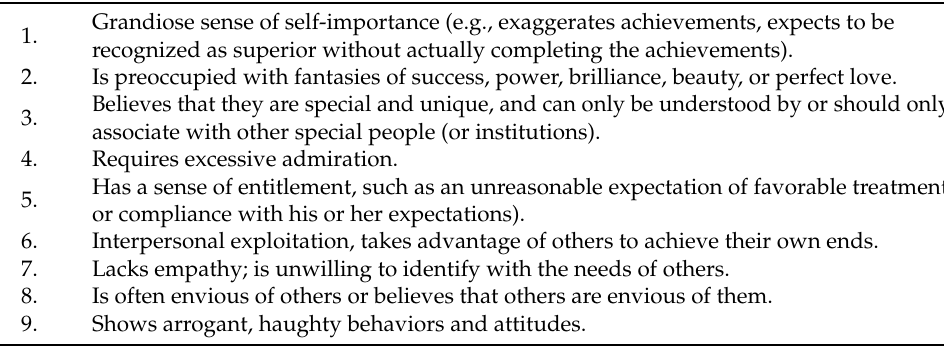
Table 1. Criteria for narcissistic personality disorder (requires at least 5